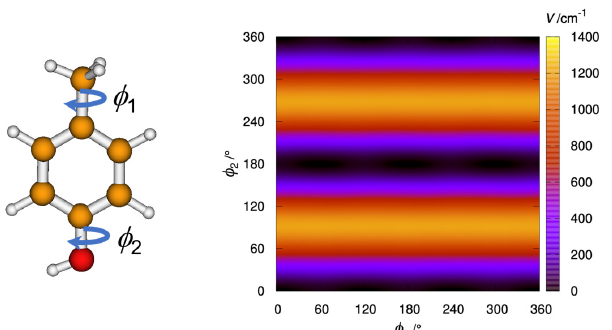
Figure 3. Contour plot showing the variation of potential energy (in cm − 1 ) with the internal rotation of the methyl (cid:4666)𝜙 (cid:2869) (cid:4667) and hydroxyl (cid:4666)𝜙 (cid:2870) (cid:4667) groups of p ‐ cresol, generated at the B3PWB91/6 ‐ rotation of the methyl ( φ 1 ) and hydroxyl ( φ 2 ) groups of p -cresol, generated at the B3PWB91/6- 311++G(d,p) level. 311++G(d,p)